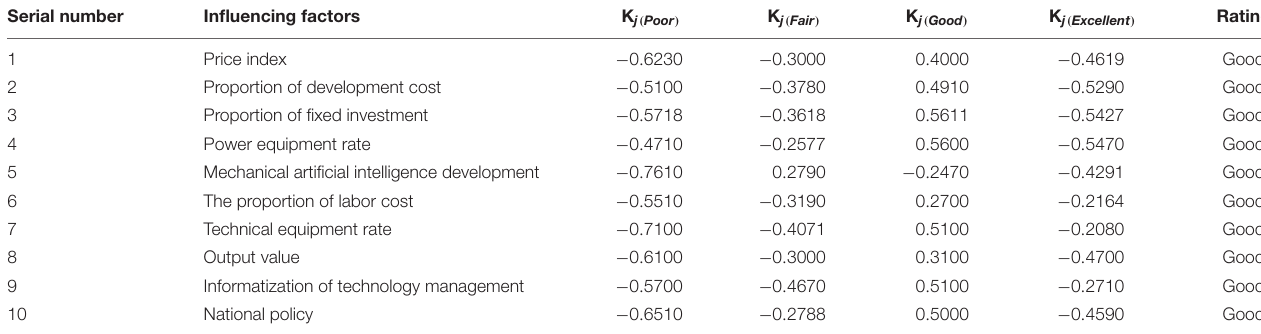
TABLE 9 | Evaluation for each